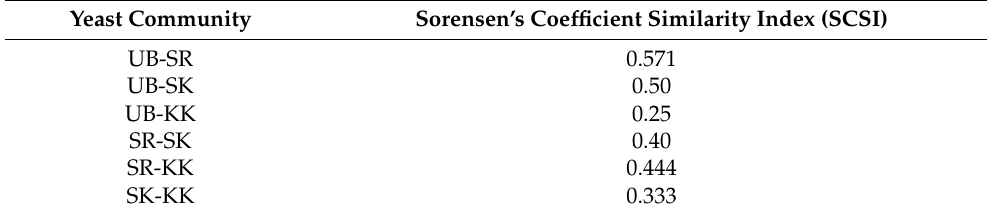
Table 6. The Sorensen’s coefficient similarity index (SCSI) of the yeast community. Yeast